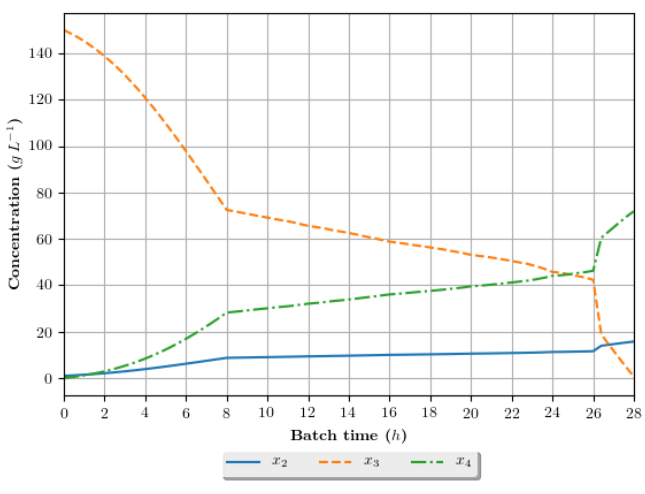
Figure 8. Growth profile for the assay of number 5 (4h/GA/exp—4h interval between DRTO cycles, GA as the optimization algorithm and exponential feed rate parametrization), in terms of the concentration of cellular biomass ( x 2 ), substrate ( x 3 ) and ethanol ( x 4 ) during the batch.